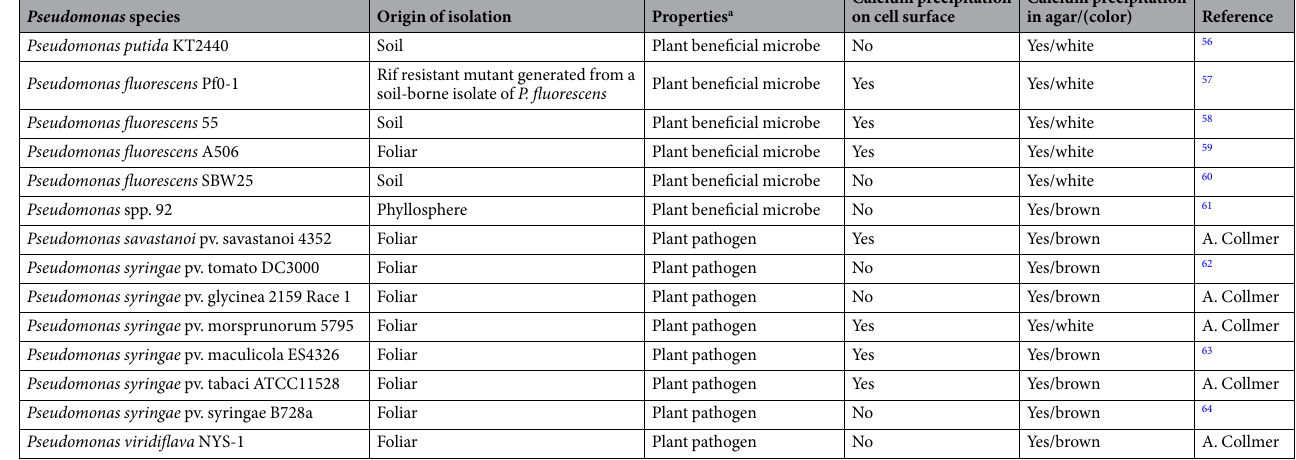
Table 1. Pseudomonas species and strains used in this work. a In reference to the main life-style of the bacteria in relation to how it associates with